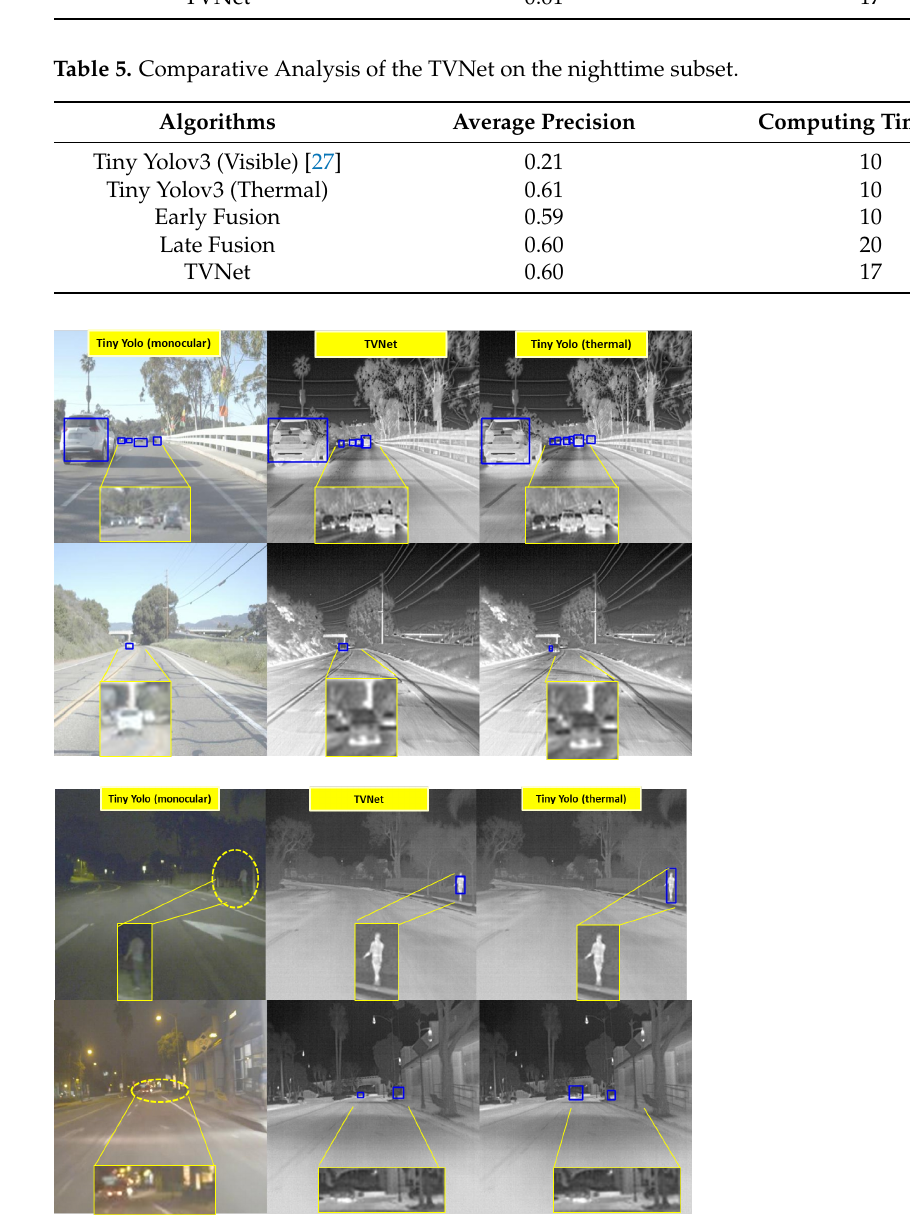
Figure 9. Detection result for the TVNet. The blue bounding boxes and yellow circle indicate the true positives and false negatives,